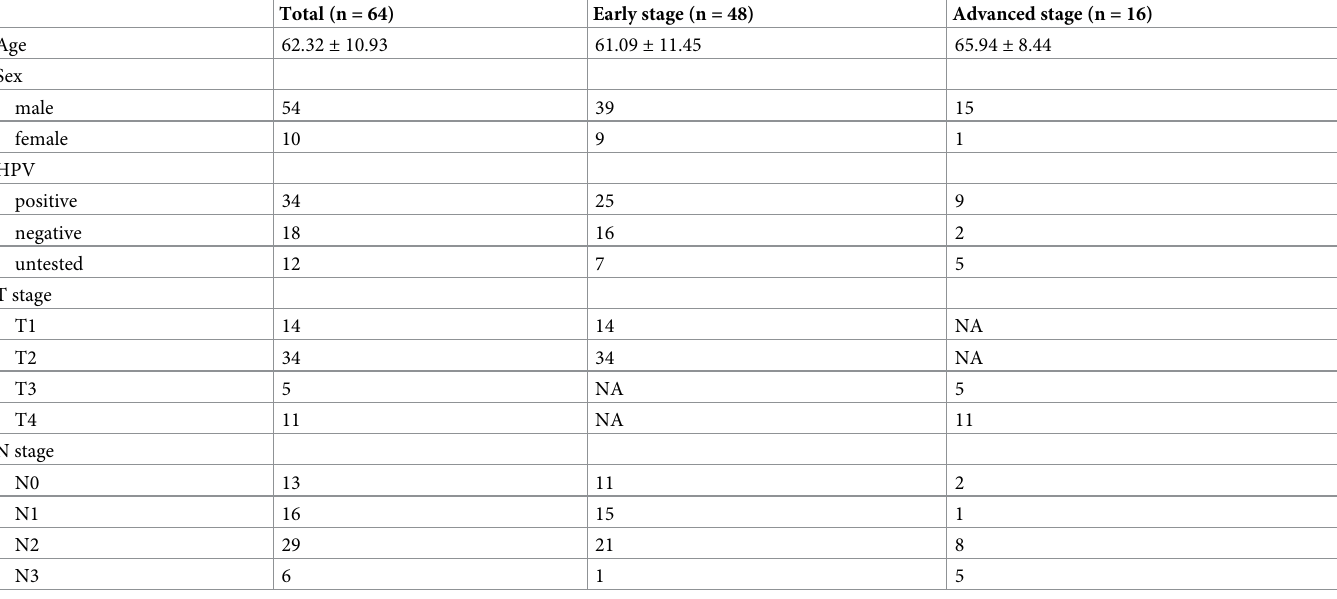
Table 1. Baseline patient and tumor characteristics.